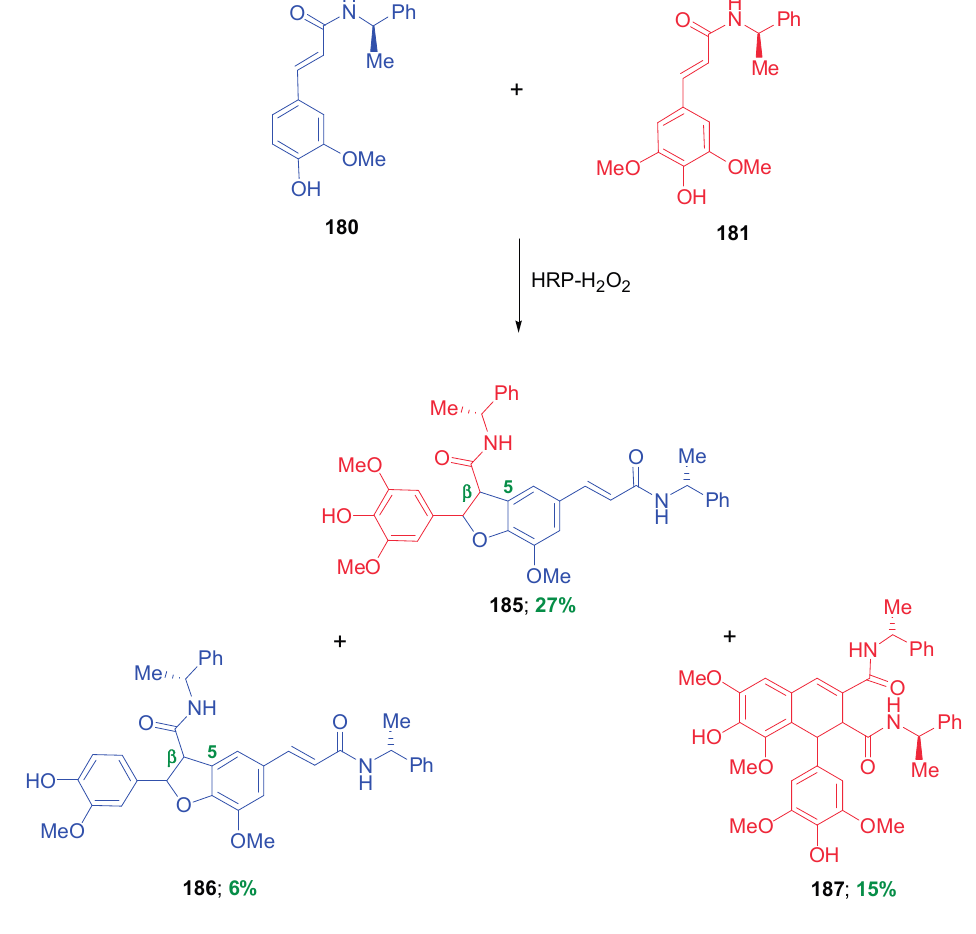
Figure 9. The structure of